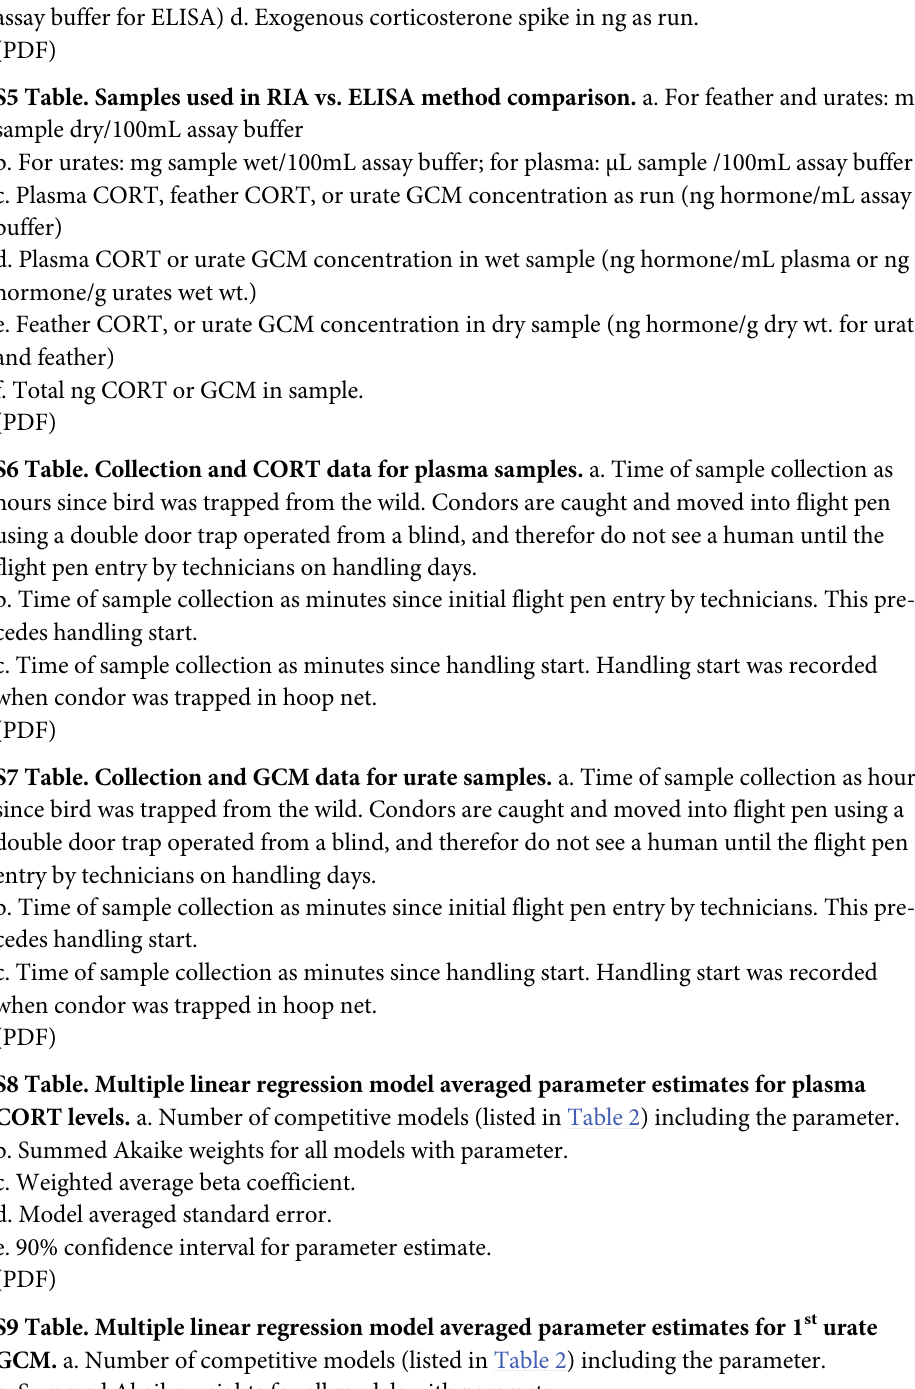
S4 Table. Analytical corticosterone (CORT) spike recovery data. a. For feather and urates: mg sample dry/100mL assay buffer